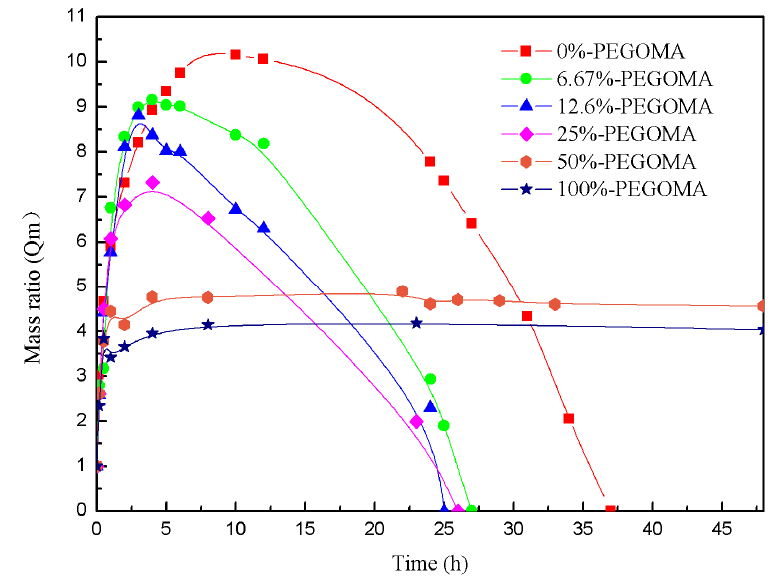
Figure 4. Mass ratio changes of different kinds of polyethylene glycol (PEG) hydrogel template (gels with different PEGOA/PEGOMA blending ratios) with time.